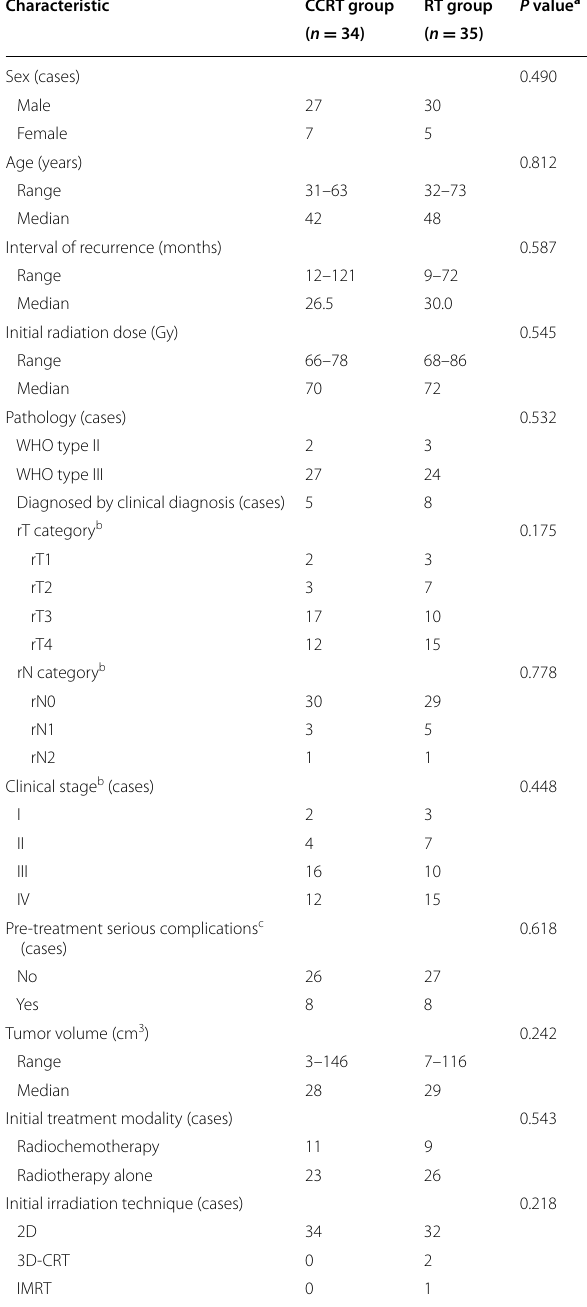
Table 1 Baseline characteristics of 69 patients with